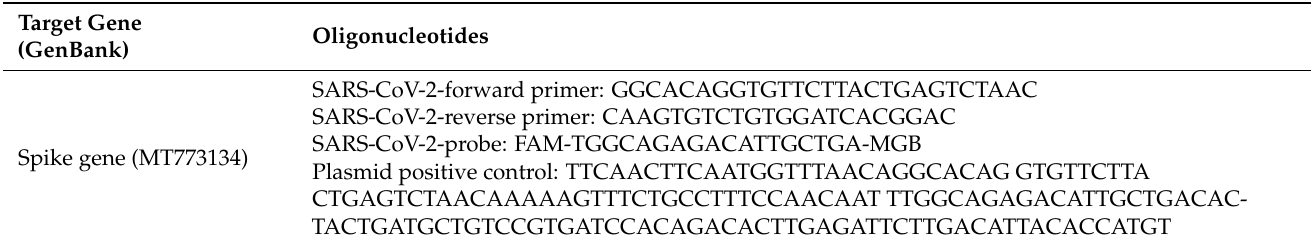
Table 1. Oligonucleotide sequences of primers, probe and positive plasmid control used to detect SARS-CoV-2 by